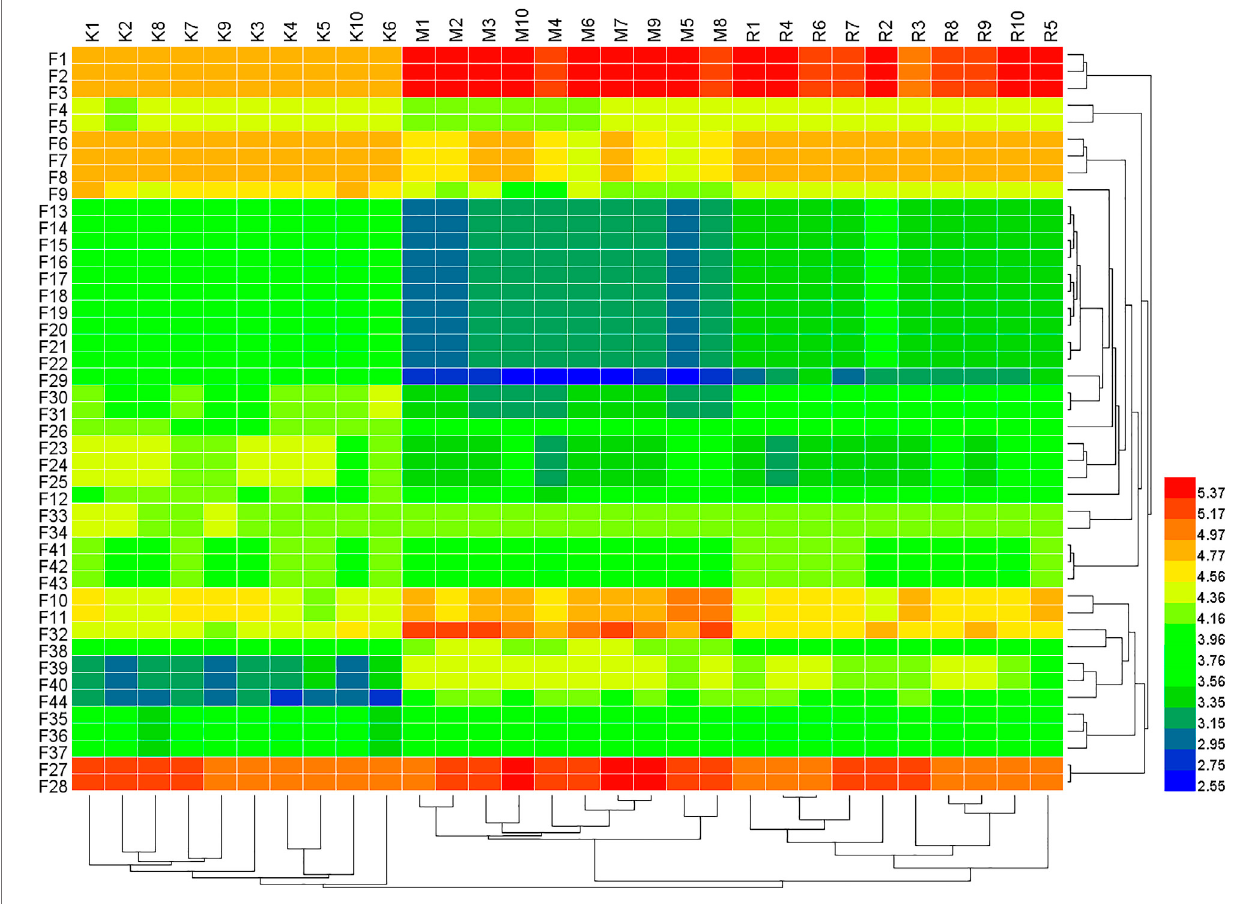
Frontiers in Pharmacology |